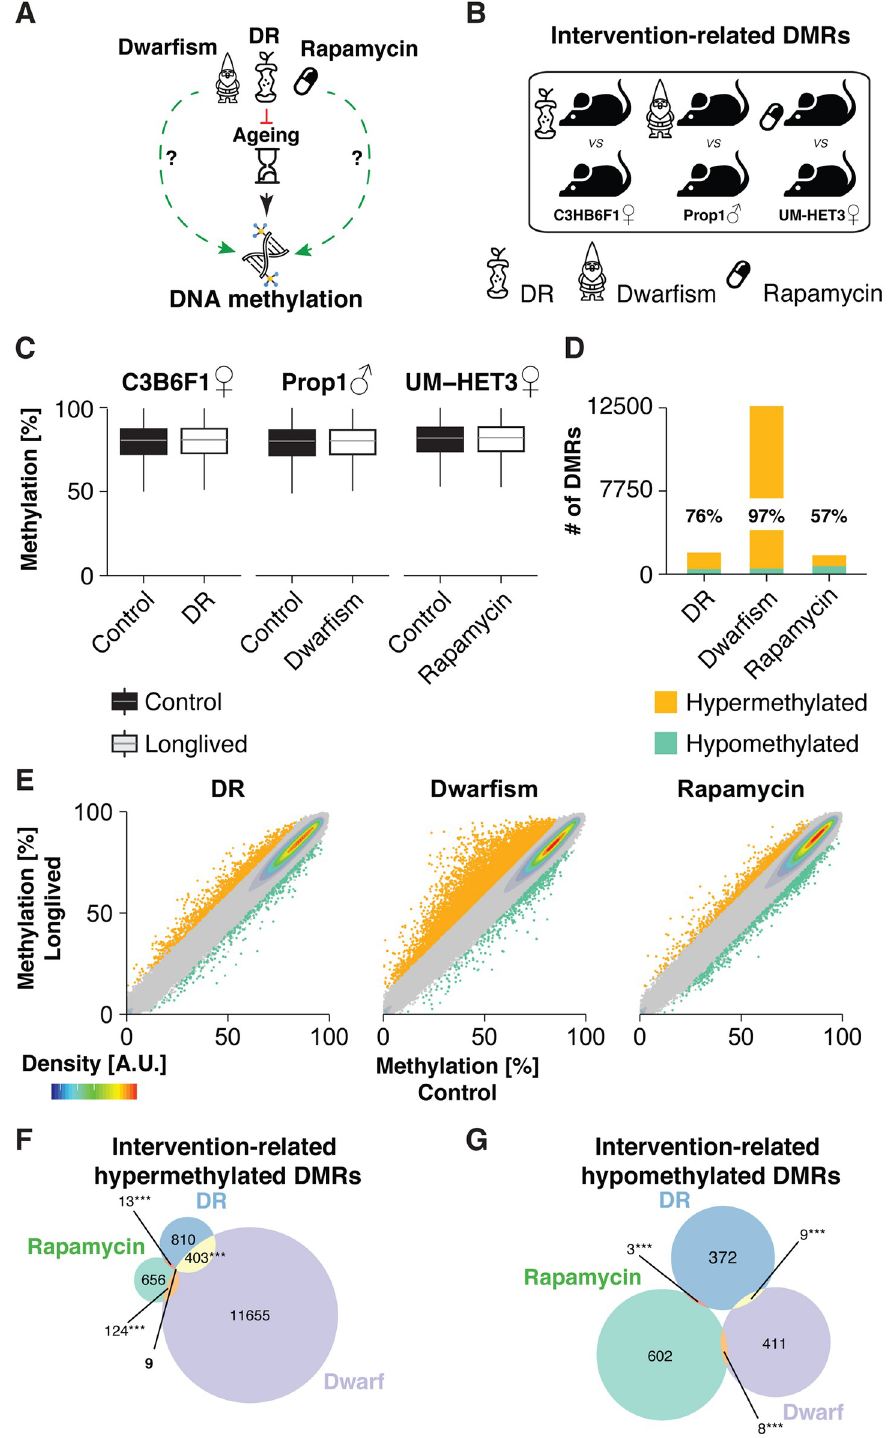
Fig 2. Cross-strain hepatic DNA methylation changes in response to longevity interventions. (A) Schematic of treatment comparisons: Various longevity interventions act on DNA methylation through retardation of ageing. We explored direct longevity-related (green arrow) effects on DNA methylation. (B) Schematic representation of the data sets analyzed and comparisons made. We probed for intervention-related DMRs at old age by comparing long-lived mice to their respective controls. Pre-processing was conducted for all shown treatment groups (C)